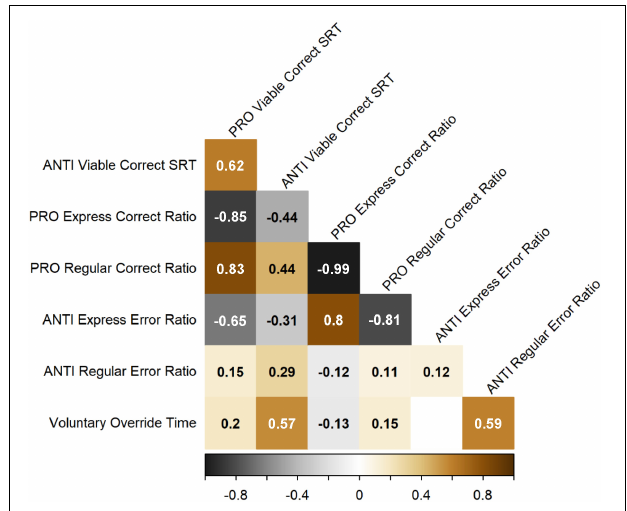
FIGURE 7 | Spearman’s correlation matrix for the seven IPAST measures of interest, after controlling for age. R values are shown for the pairwise relationships between each measure, with warm colors indicating positive correlations and cool colors indicating negative correlations. Only significant correlations ( p < 0.05) are